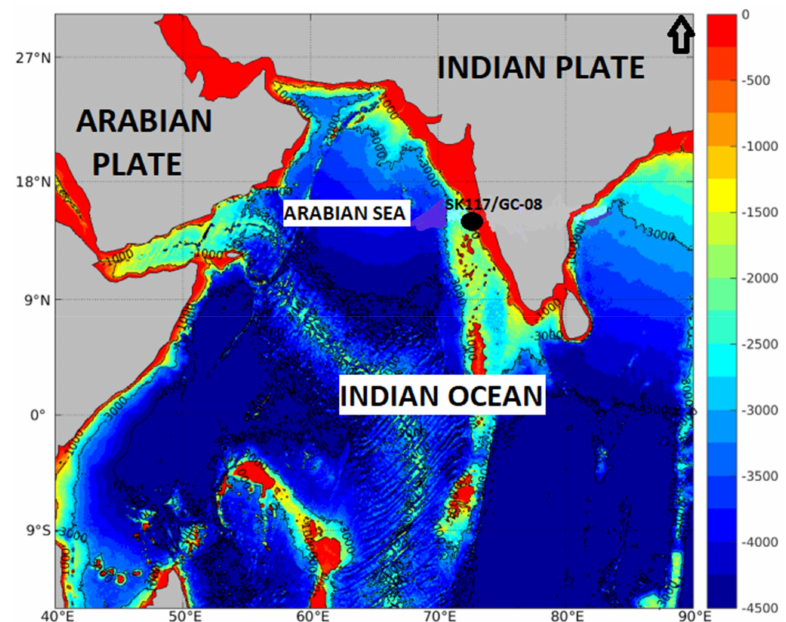
Figure 1. Location of the sediment core is shown in the eastern Arabian Sea in the northern Indian Ocean